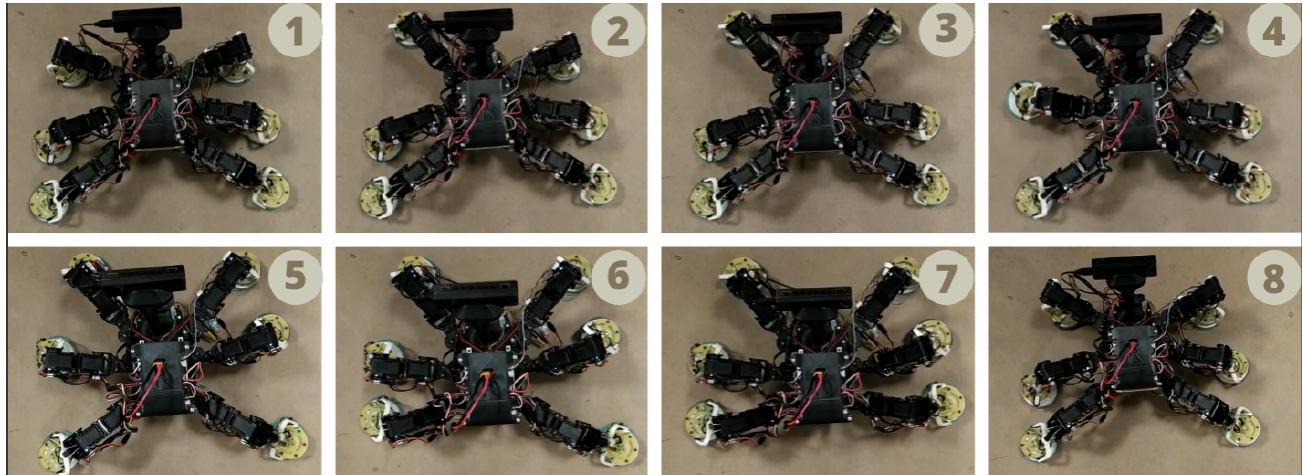
Figure 9. Motion sequences during a walking pattern with